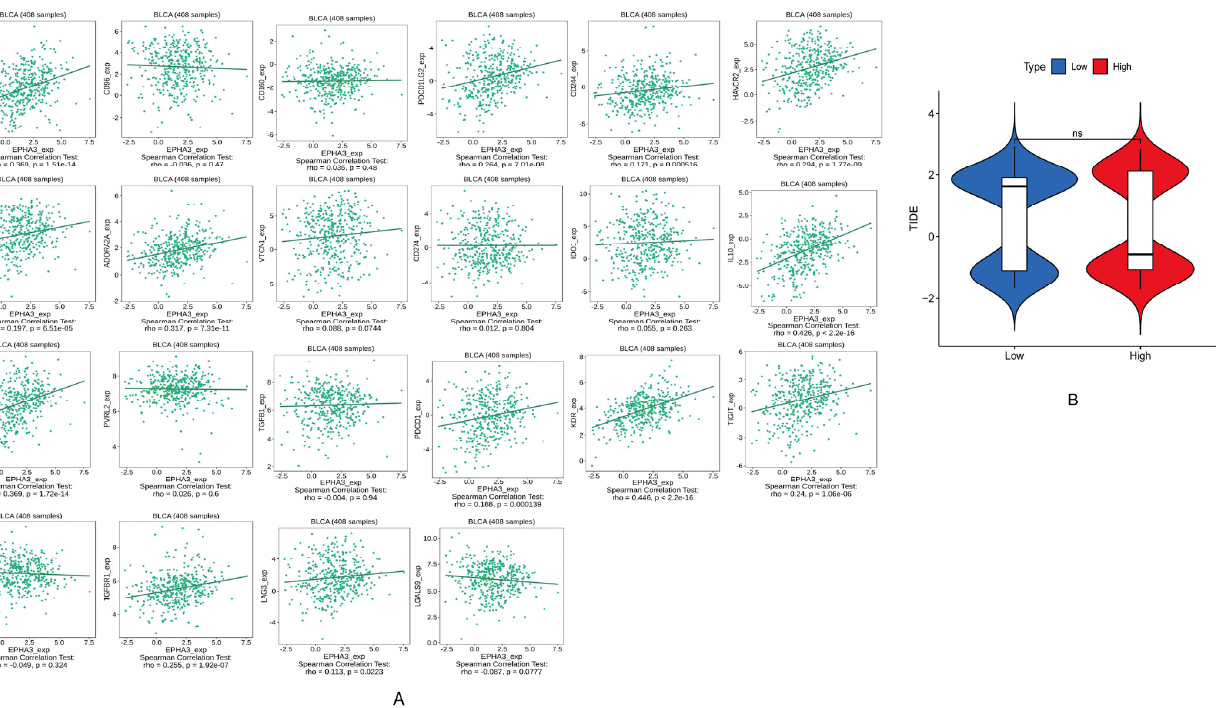
Figure 13. (A ) Association of EPHA3 level with immune cell infiltration levels in TCGA-BLCA. ( B ) The correlation of EPHA3 level with 24 common immune-infiltrating cells was evaluated by ssGSEA. ( C ) Scatter plots indicating EPHA3 level with 24 common immune cell infiltration levels based on the TIMER method. ( D ) Scatter plots indicating EPHA3 levels with 10 common immune cell infiltration levels using MCP-counter algorithm. ( E ) The stromal, immune, and ESTIMATE scores between the high and low EPHA3 expression groups were explored using the ESTIMATE algorithm. *** p < 0.001.